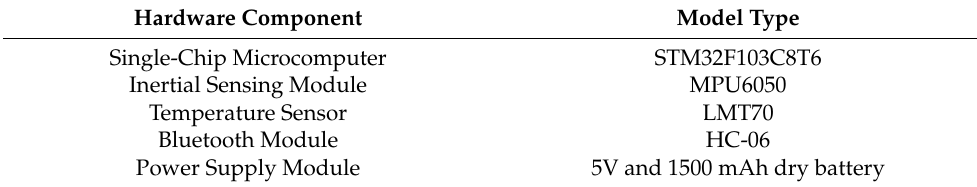
Figure 2. Hardware structure of the wearable device. Table 1. Hardware